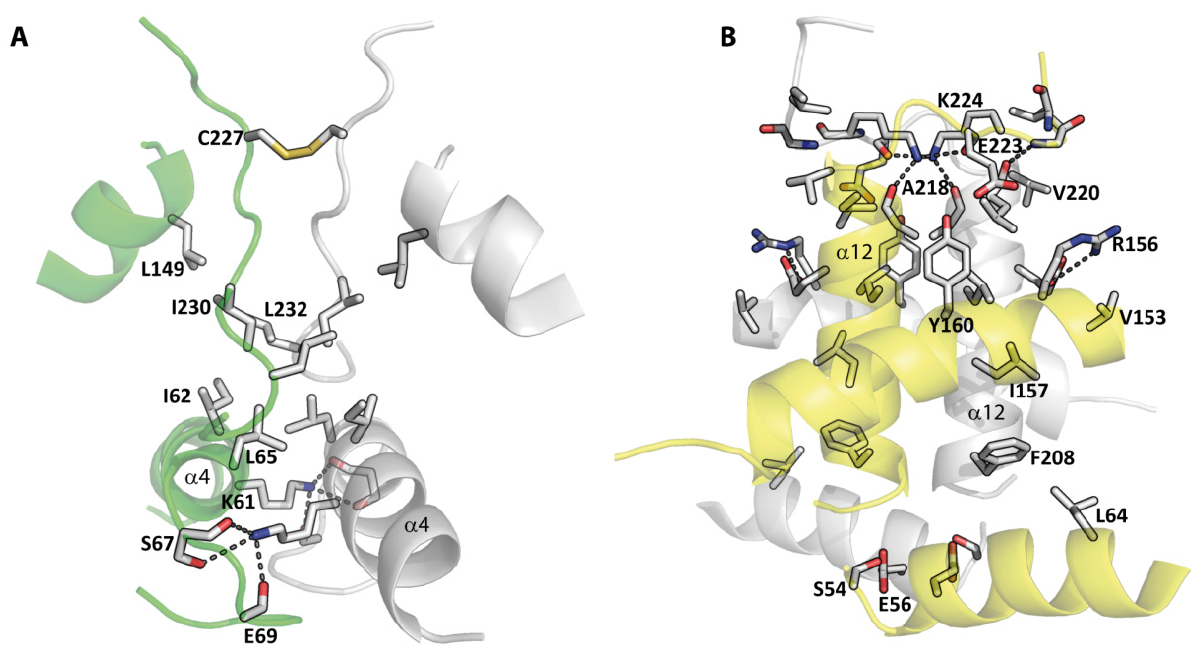
Figure 3. Schematic representation of the dimer interfaces in r Mro UPO ( A ) and r Cvi UPO ( B ). Subunits of the dimers are shown in gray and green for r Mro UPO, and gray and yellow for r Cvi UPO. Hydrogen bonds and salt bridges together with hydrophobic interactions contribute to the stability of the dimers, together with the C227 ‐ C227 ′ disulfide bridge and the parallel associa ‐ tion of the two α 12 helices (also see Figure 1).